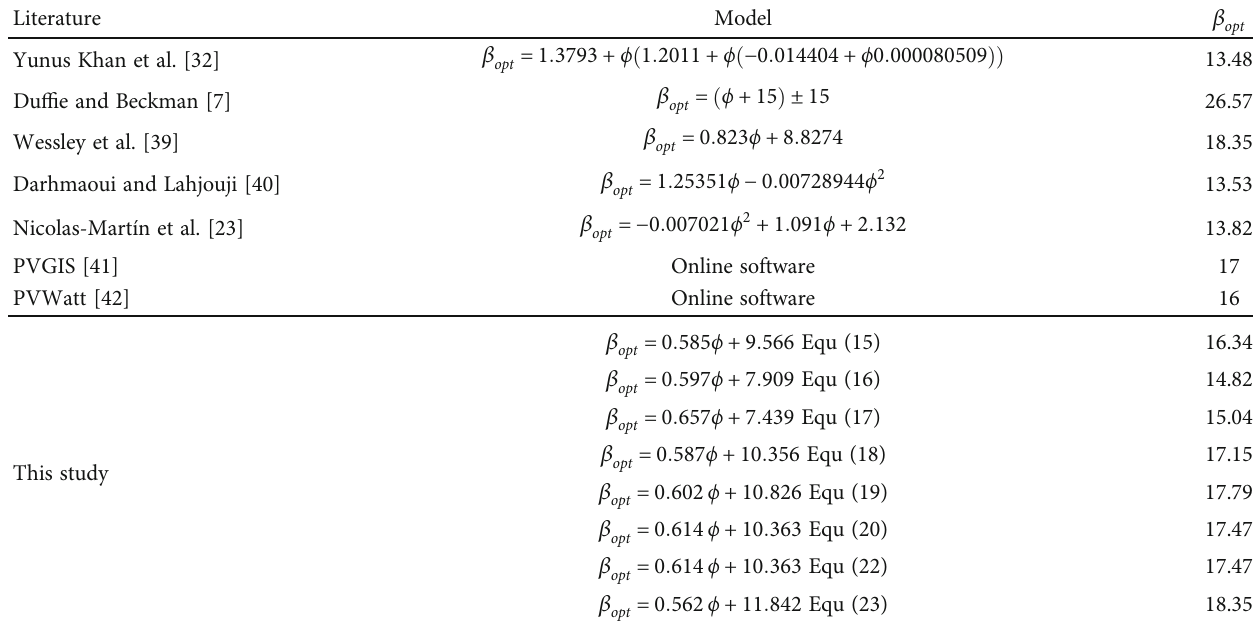
Table 8: Annual optimal tilt angle of Bahir Dar city by this study, literature, and online